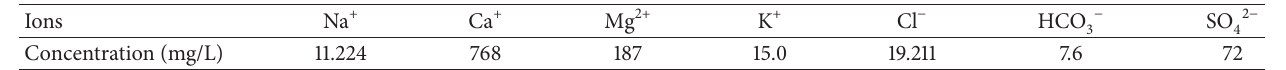
Table 3: Ion content and salinity of brine.